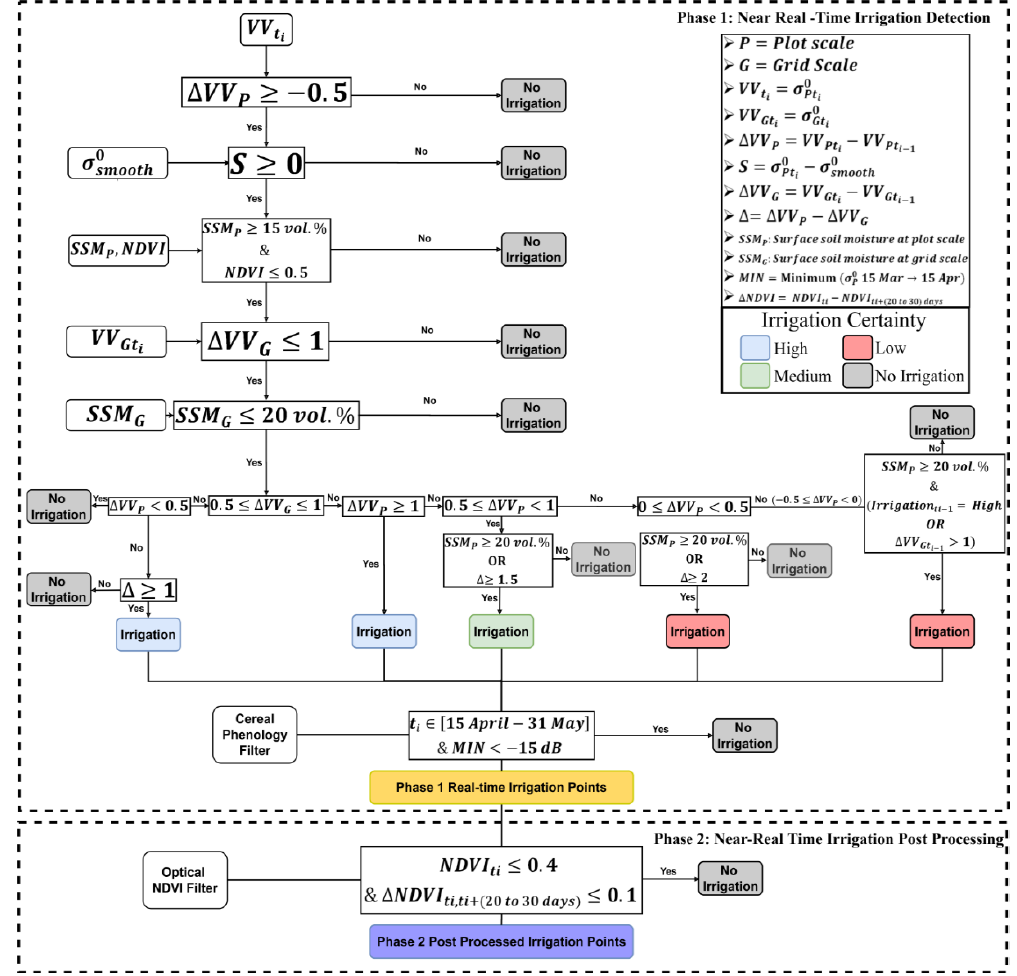
Figure 3. Workflow overview using the tree-based classification for irrigation detection at plot scale.